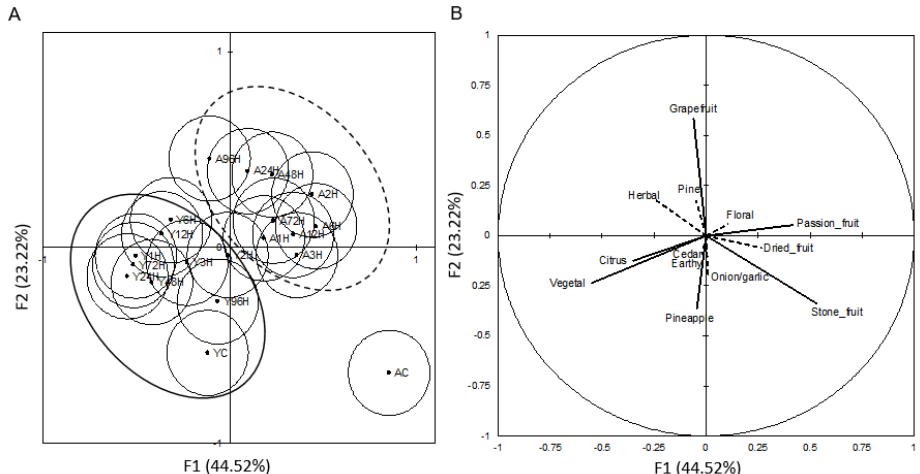
Figure 5. Canonical variance analysis of the sensory data for the young (Y) and aged (A) beers with different hop exposure times. ( A ) Score plot showing the grouping of young (solid oval) and aged beers (broken line oval) ( n = 3). ( B ) Variable plot showing the ballot attributes that are significant (solid line) and not significant (broken line). Confidence intervals were determined at 95%.